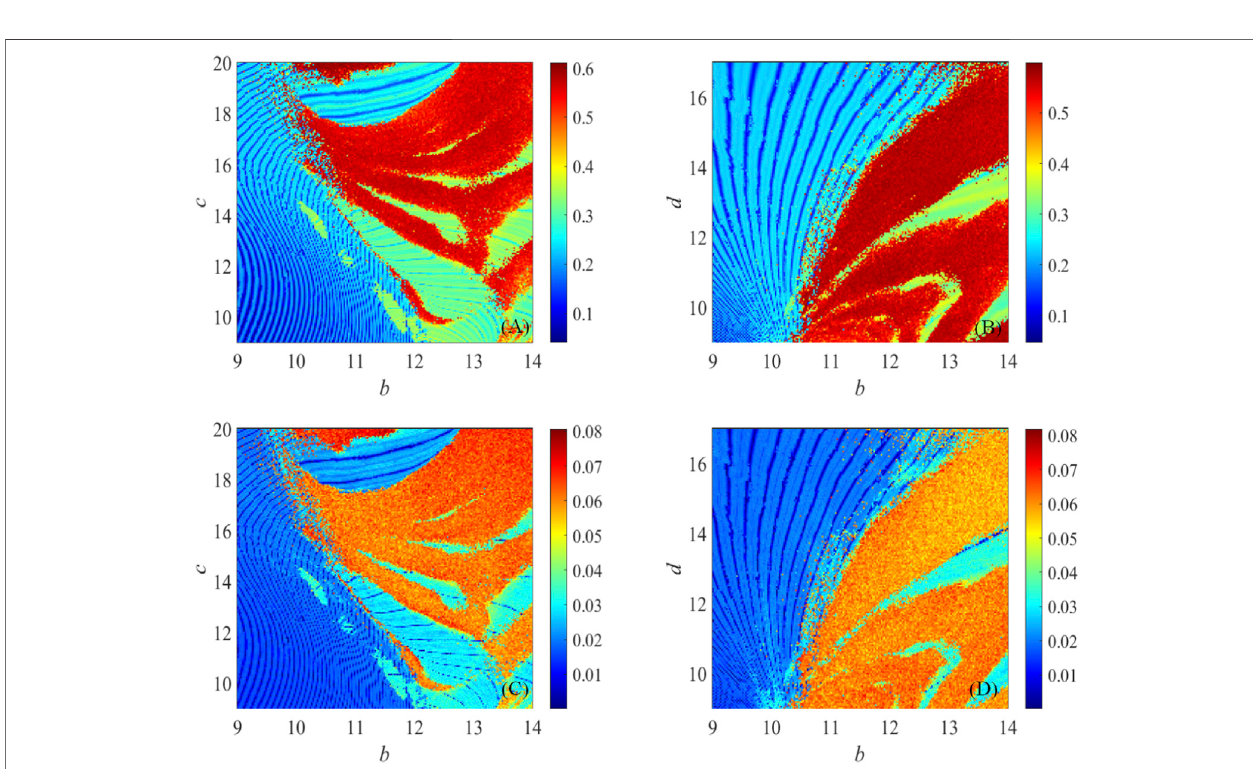
FIGURE 8 | (A) bifurcation diagram (B) Lyapunov exponent spectrum.